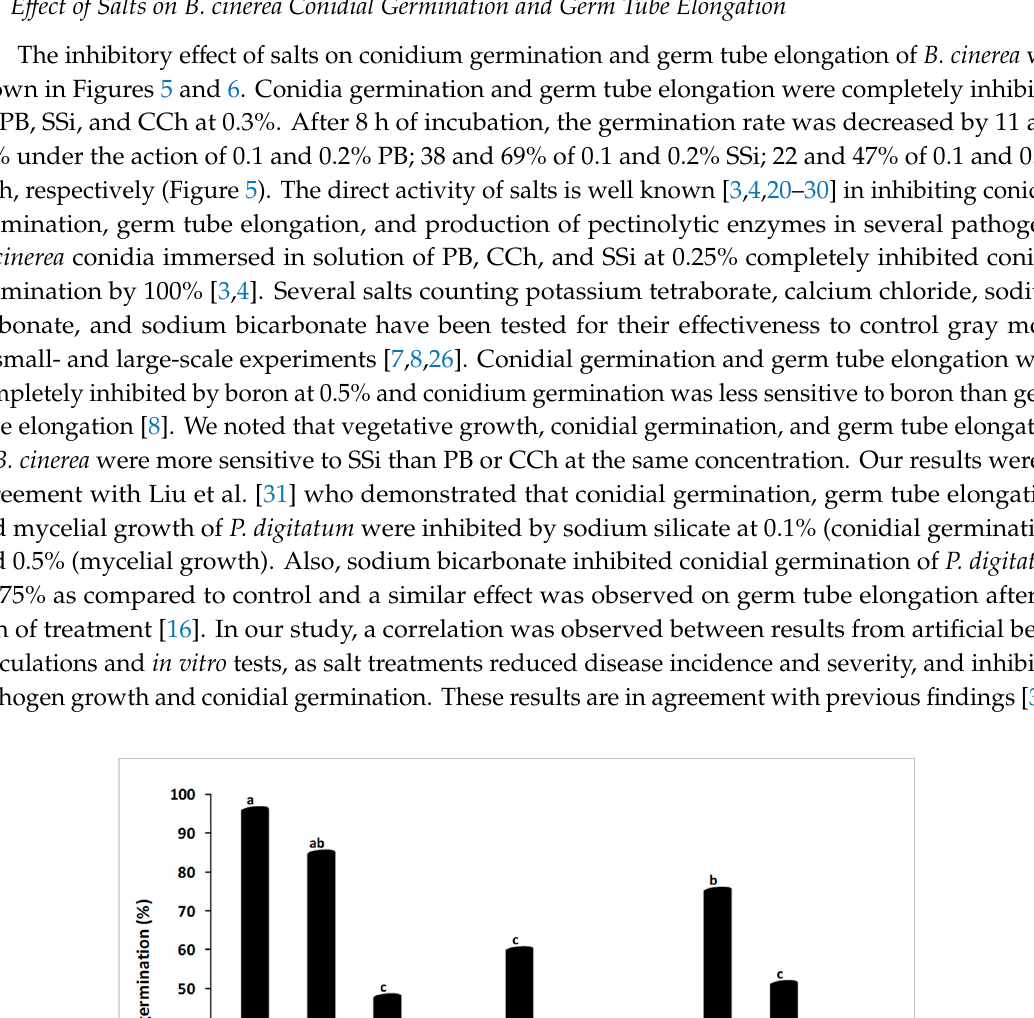
Figure 6. Effect of potassium bicarbonate (PB), sodium silicate (SSi), and calcium chelate (CCh) on germ tube elongation ( μ m) of Botrytis cinerea in potato dextrose broth after 8 h of incubation at 23 ± 1 º C. Values marked with the same letters are not statistically different by Fisher’s protected least significant difference test at p ≤ 0.05. 3.4. Scanning Electron Microscopy (SEM) Morphological damage was detected in the hyphae treated with PB, SSi, and CCh compared to the hyphae in the control. Shriveled hyphae were commonly observed in salt-treated mycelia compared with the control-normal mycelia. Control demonstrating hyphae with typical ‘net’ structure and smooth surface while salt-treated hyphae lost their smoothness and formed unusual bulges on its surface. Defects such as malformation and excessive septation were detected on salt-treated hyphae morphology (Figure 7). SEM was previously used to demonstrate the morphology alternation of fungal hyphae, especially B. cinerea due to the treatment with various compounds. The direct examination by SEM indicated that the high concentration of nanoscale silicate (1000 mg L − 1 ) could cause conidium and mycelia shrinkages of B. cinerea [32]. Also, silver nanoparticles caused Quercus wilting and damaged the mycelia of Raffaelea sp. [33] or Colletotrichum acutatum [34]. ZnO nanoparticles caused the defects for mycelia of B. cinerea and conidiophore of